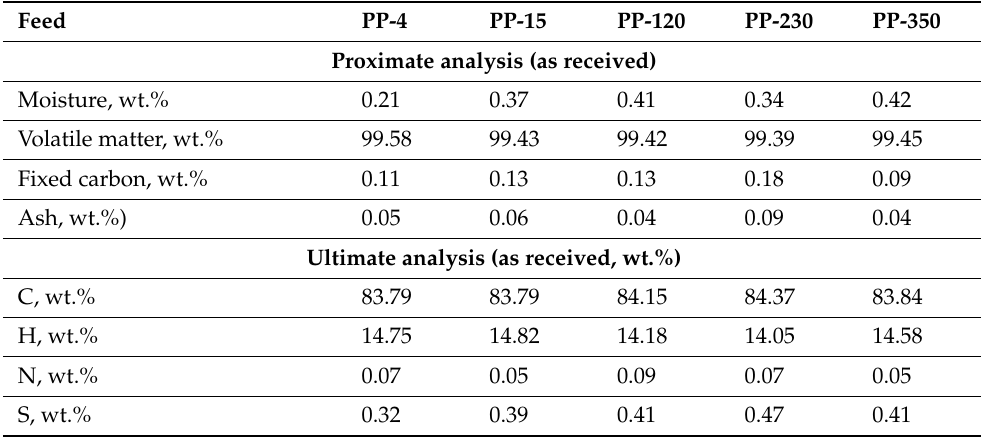
Table 1. Elemental analysis of the PP samples with different concentrations of iron